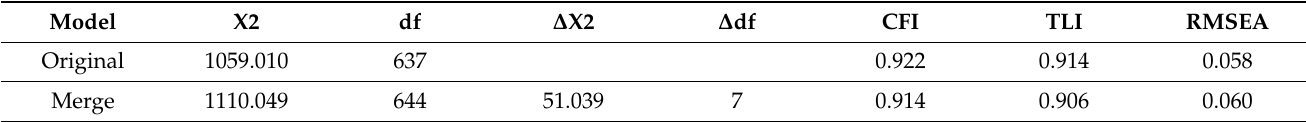
Table 5. Discriminative validity reasoning based on Bagozzi and Yi.